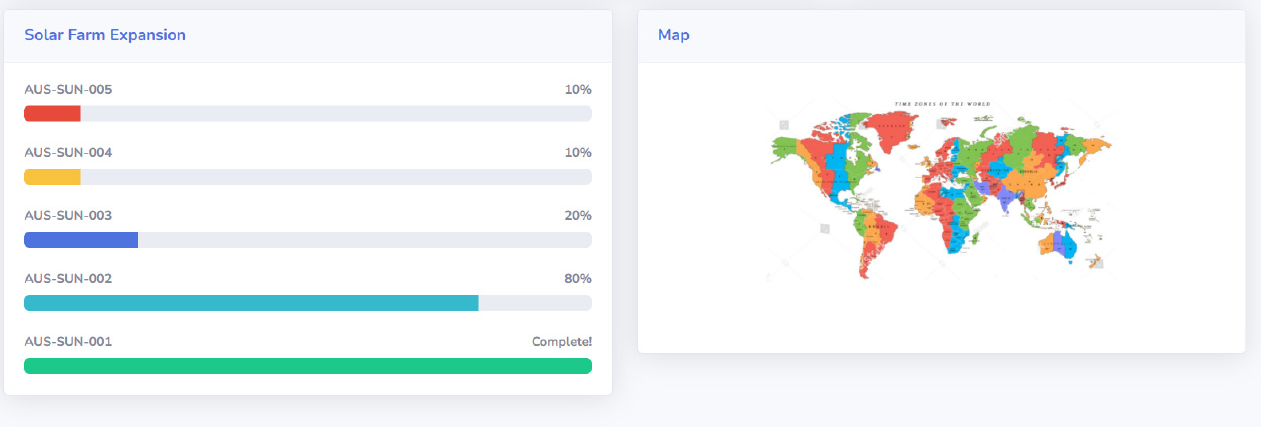
Figure 8. Admin dashboard overview—facility information.